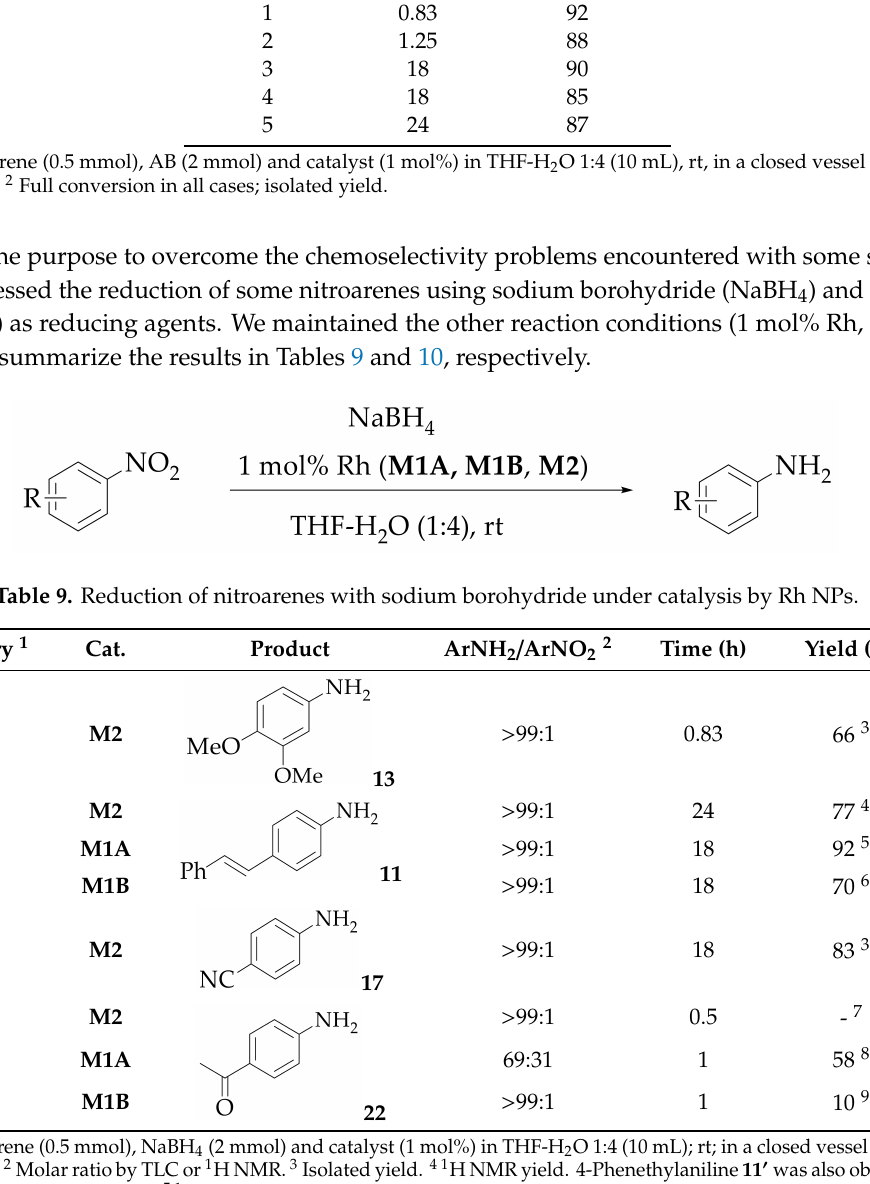
Table 8. Recycling of Rh NPs ( M1A ) in the reduction of 3,4-dimethoxynitrobenzene with AB. Cycle 1 Time (h) Yield (%) 2 1 0.83 92 2 1.25 88 3 18 90 4 18 85 24